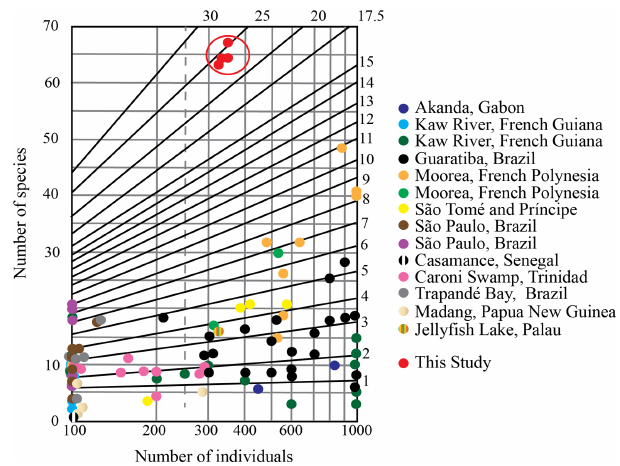
Figure 2. Fisher α diversity index graph for foraminiferal samples from the Mamanguape River estuary in comparison to total assem- blages reported in previous mangrove studies (data from Brönni- mann et al., 1981 (Guaratiba, Brazil); Rouvillois, 1982 (Casamance, Senegal); Lipps and Langer, 1999 (Jellyfish Lake, Palau); Debe- nay et al., 2002, 2004 (Kaw River, French Guiana); Langer and Lipps, 2003 (Madang, Papua New Guinea); Langer and Lipps, 2006 (Moorea, French Polynesia); Wilson et al., 2008 (Trinidad); Fajemila et al., 2015 (Moorea, French Polynesia); Langer et al., 2016 (Akanda, Gabon); Fajemila and Langer, 2017 (Sao Tome and Príncipe); Eichler, 2018 (Sao Paulo, Brazil); and Semensatto et al., 2009 (Trapandé Bay,